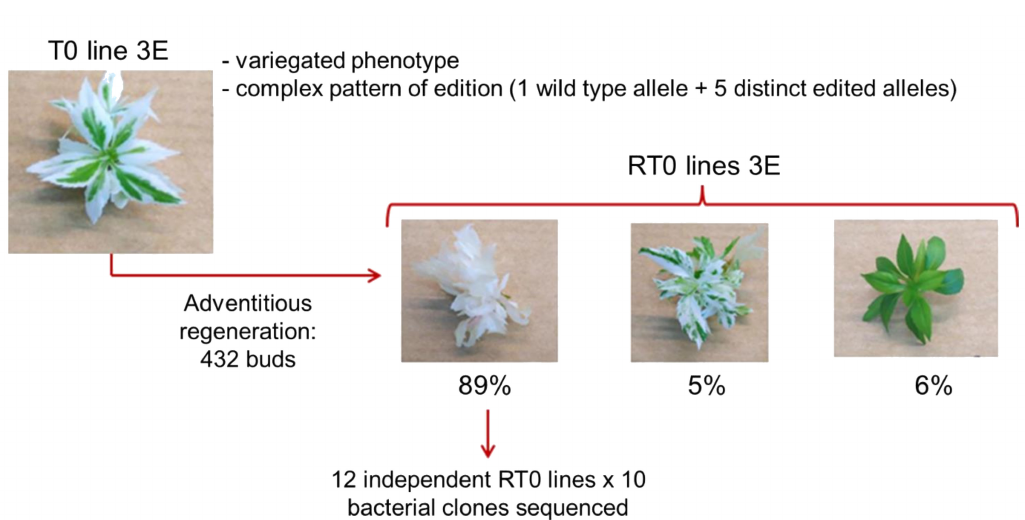
Figure 1. Scheme of assessment of adventitious regeneration efficiency to reduce phenotypic and editing chimerism in a CRISPR-Cas9 edited apple